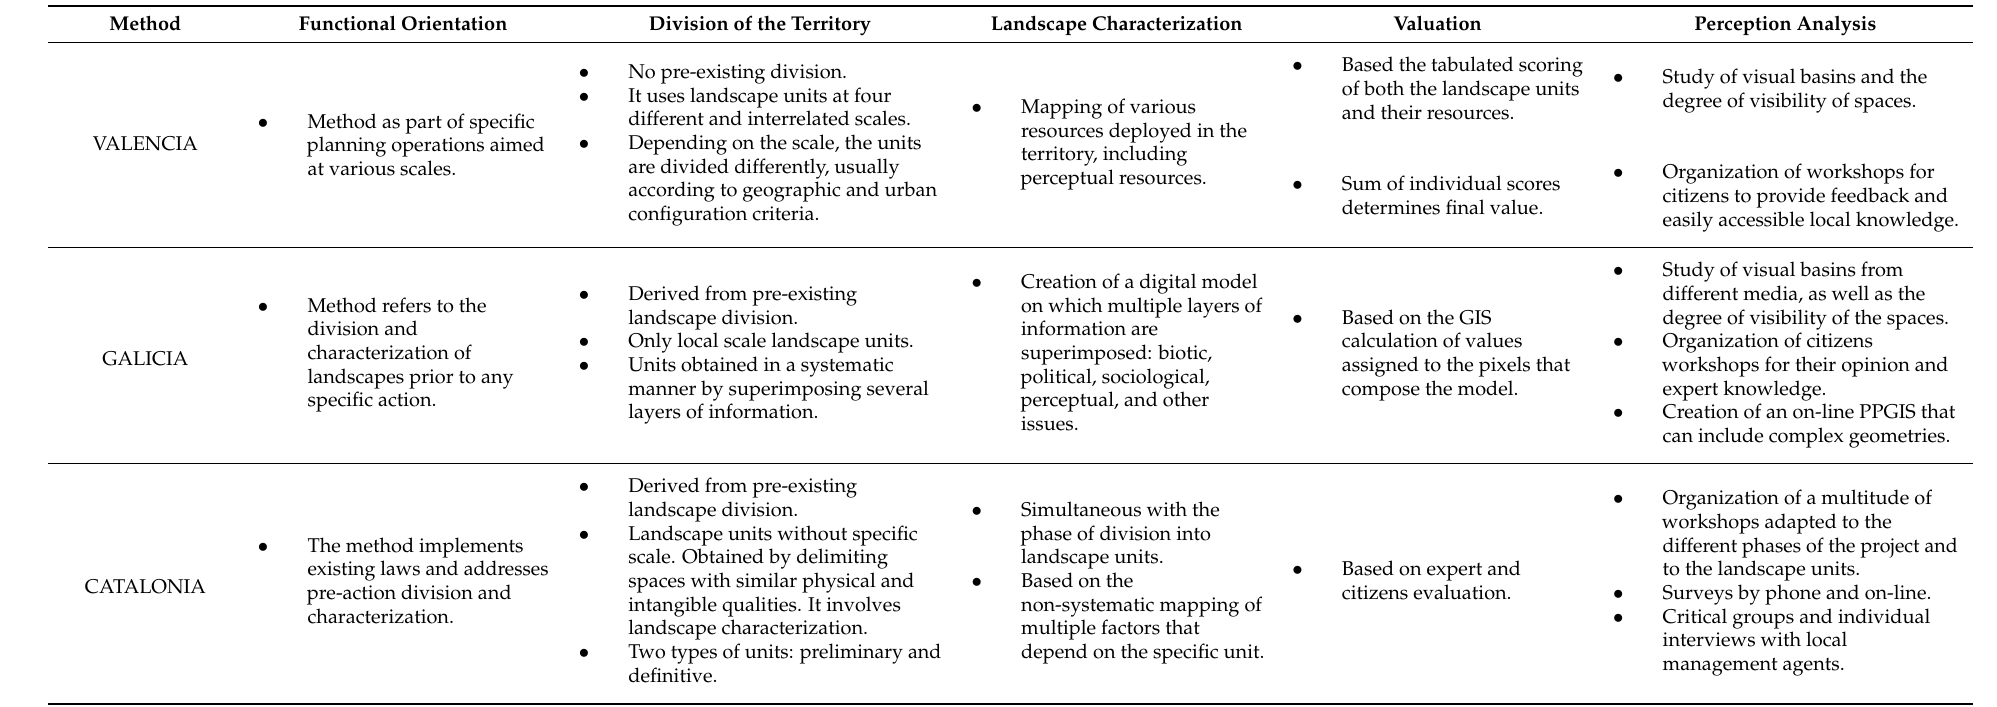
Table 1. Phase Comparison of method